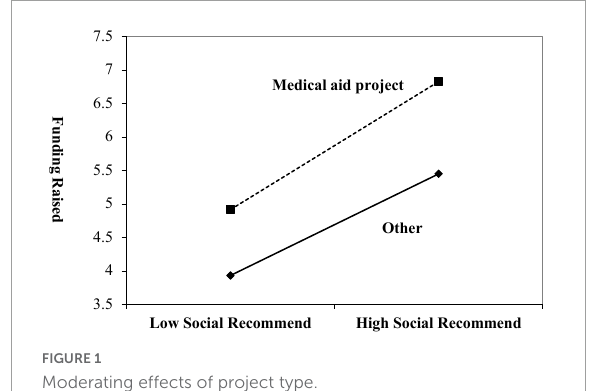
FIGURE1 Moderating effects of project